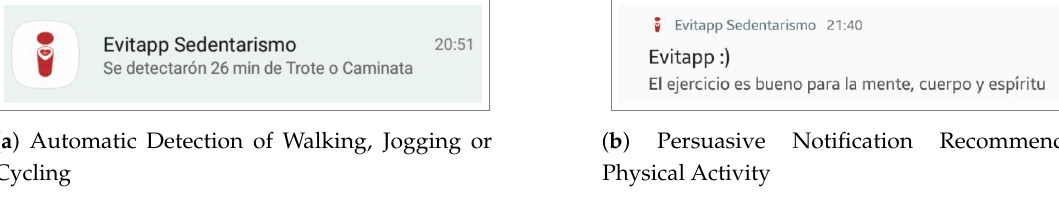
Figure 5. Examples of Notifications from the Smoke Cessation